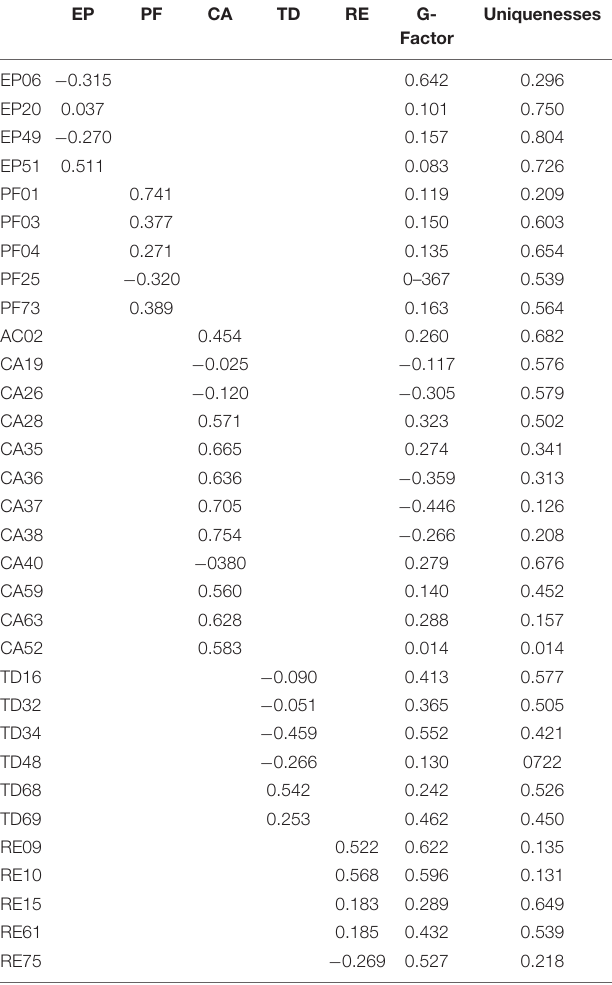
TABLE 6 | Standardized factorial loads of the